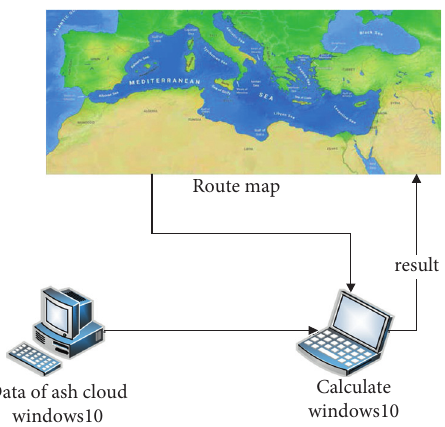
Figure 9: Simulation experiment environment.